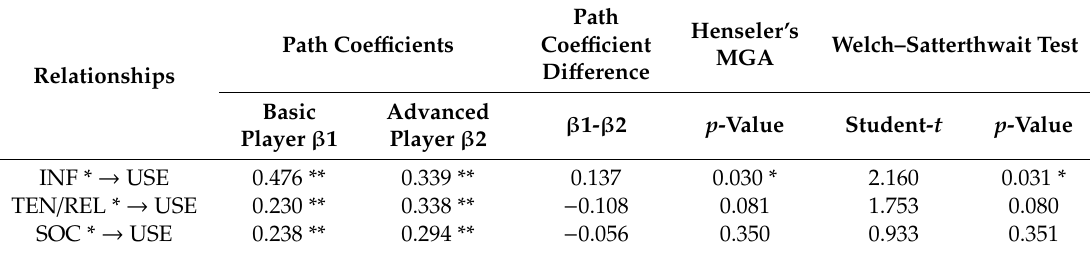
Table 6. Multi-group analysis by self-perception of level as a